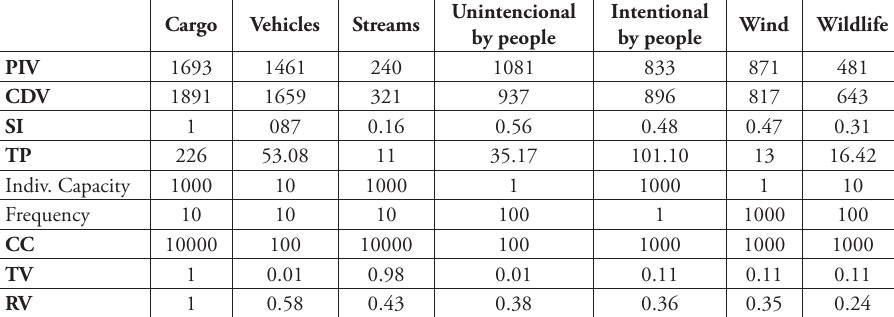
Table 1. Vectors characterization. Potential impact (PIV), control difficulty (CDV), severity of impact (SI), transportable propagules (TP), individual transport capacity, activity frequency, carrying capacity (CC), transportable volume (TV) and resulting risk (RV) for vectors capable of transporting invasive and potentially invasive alien plants present in intensive use zones of the Ernesto Tornquist Provincial Park and it’s surroundings (Buenos Aires,